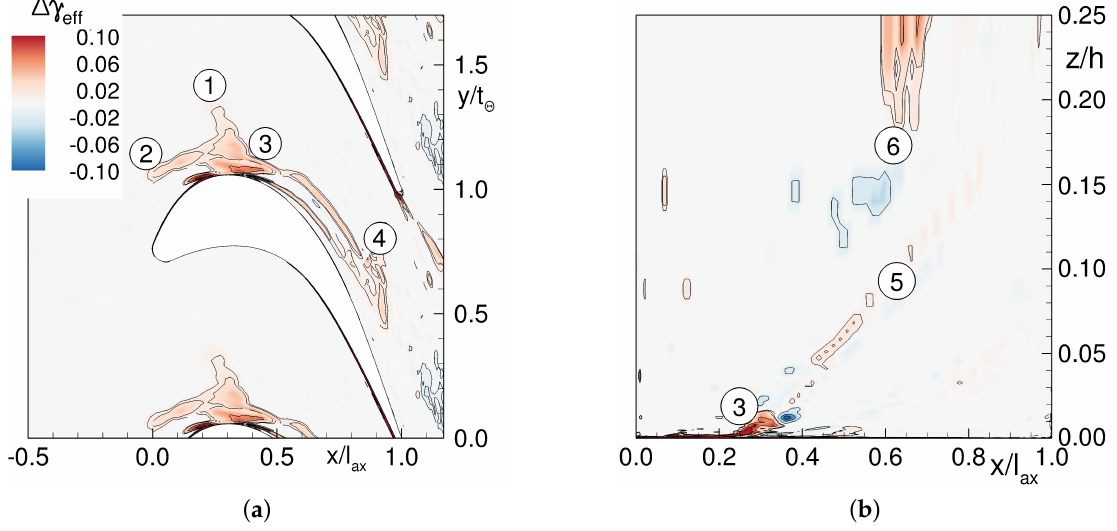
Figure 2. Comparison of numerical predicted intermittency γ ef f , dif f ( γ ef f according to the original γ -Re Θ transition model [3]) with (VB-CF) and without (VB) cross-flow extension. ( a ) Sidewall; ( b ) Suction